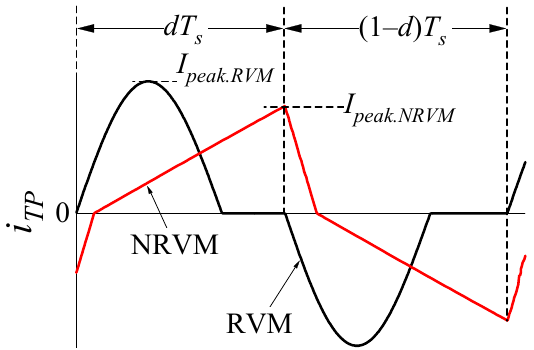
Figure 11. Waveform comparison between NRVM and RVM.